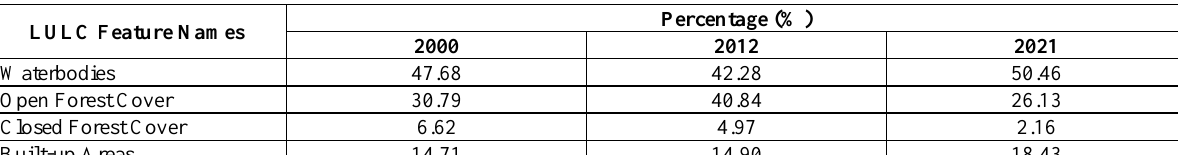
Table 2. Land Use Land Cover Classification